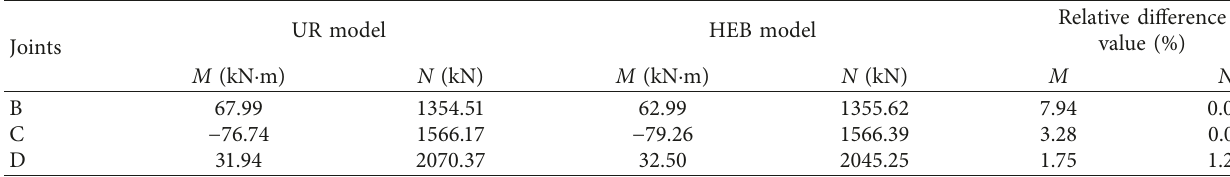
Table 2: Calculation results of inner force on joints section.